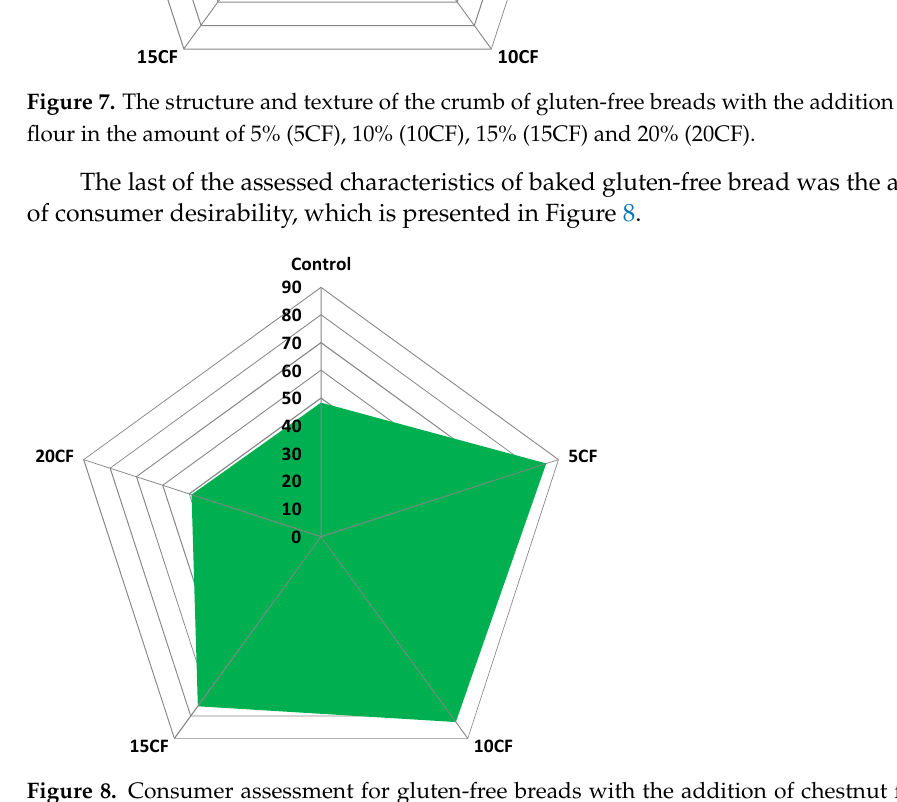
Figure 8. Consumer assessment for gluten-free breads with the addition of chestnut flour in the amount of 5% (5CF), 10% (10CF), 15% (15CF) and 20% (20CF).